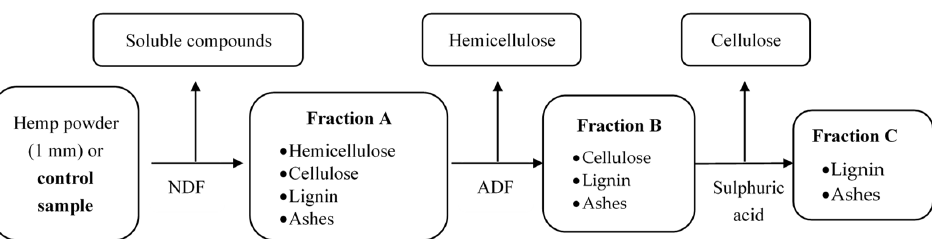
Figure 1. Chemical composition of Van Soest fractions.